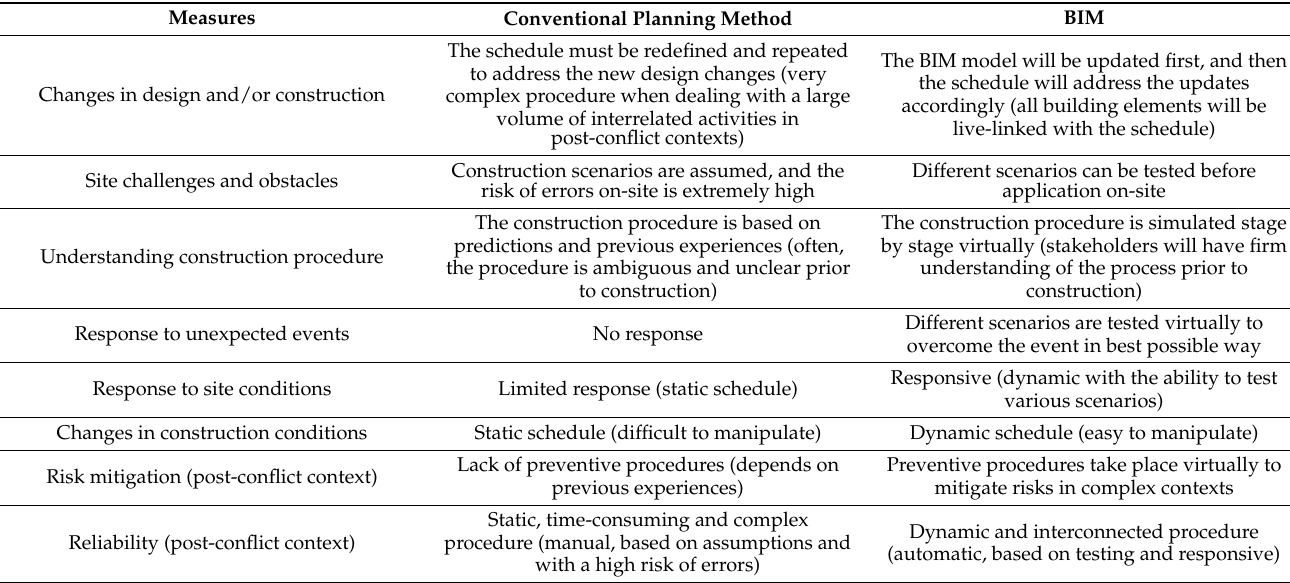
Table 2. Conventional planning method vs. 4D BIM applications.